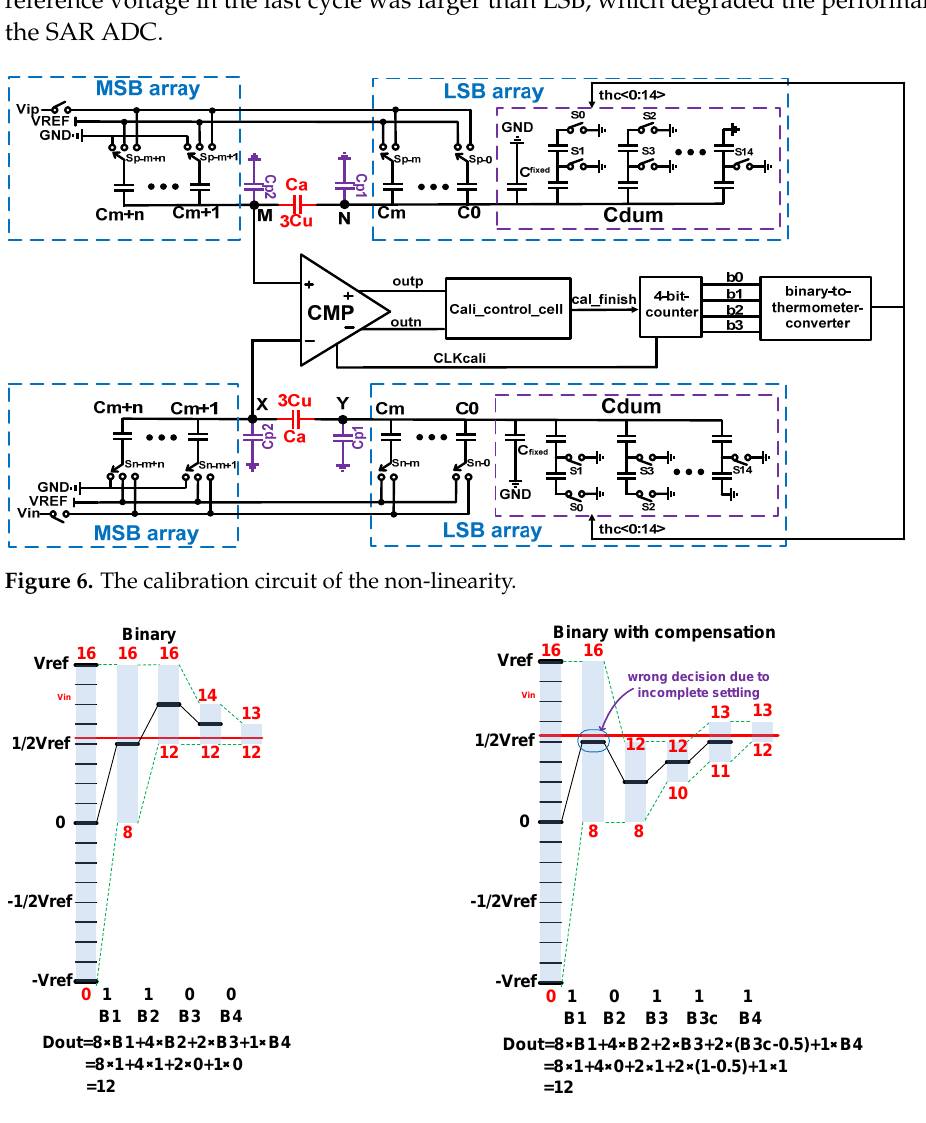
Figure 7. Binary − scaled compensation. ( a ) Correction conversion; ( b ) conversion with a wrong de- cision.